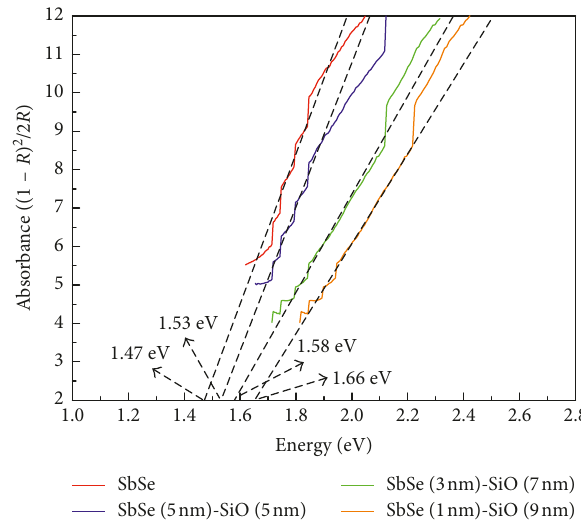
Figure 3: The Kubelka–Munk function of amorphous SbSe and SbSe (1nm) SiO (9nm) multilayer thin films.